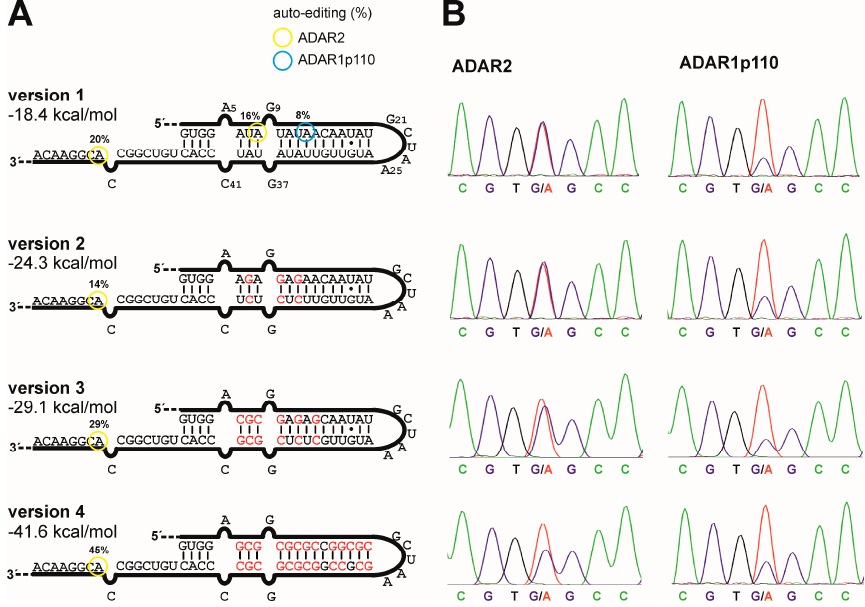
Figure 3. GuideRNA variants that avoid auto ‐ editing. ( A ) Three guideRNA versions with differing degree of G/C substitution were tested for auto ‐ editing. The shown sequence was introduced into the 3 ′‐ UTR of the eGFP transcript for easier Sanger sequencing. The folding energies have been estimated using mfold. For ADAR1p150, no auto ‐ editing site was detectable; ( B ) Performance of the three new guideRNA versions for the editing of W58x with ADAR2 or ADAR1p110, respectively, when applied in trans in the respective ADAR ‐ expressing cell line. For fluorescence imaging, see Figure S5.